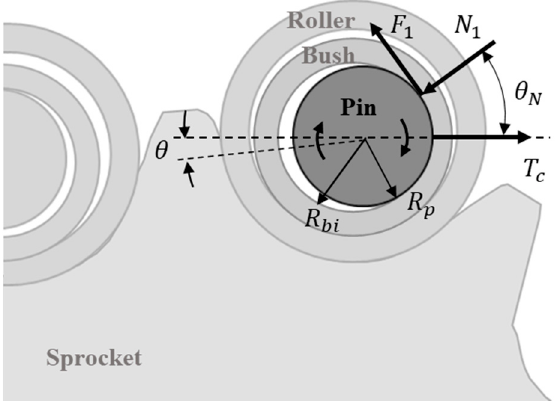
Figure 2. Schematic of contact for pin articulation.